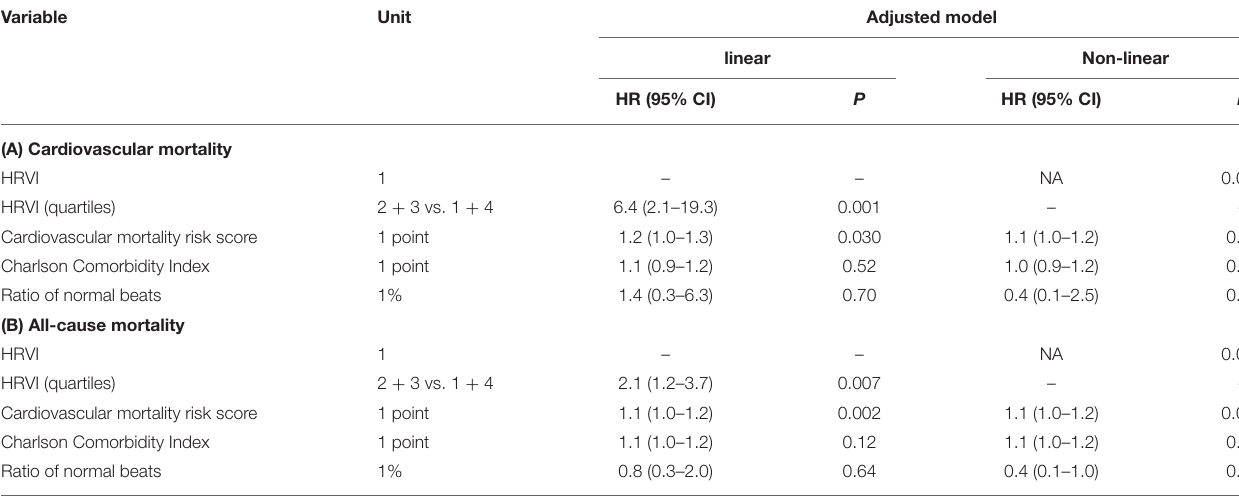
TABLE 6 | Sensitivity analysis of adjusted linear and non-linear Cox regression models additionally including the ratio of normal beats for (A) cardiovascular and (B) all-cause mortality.